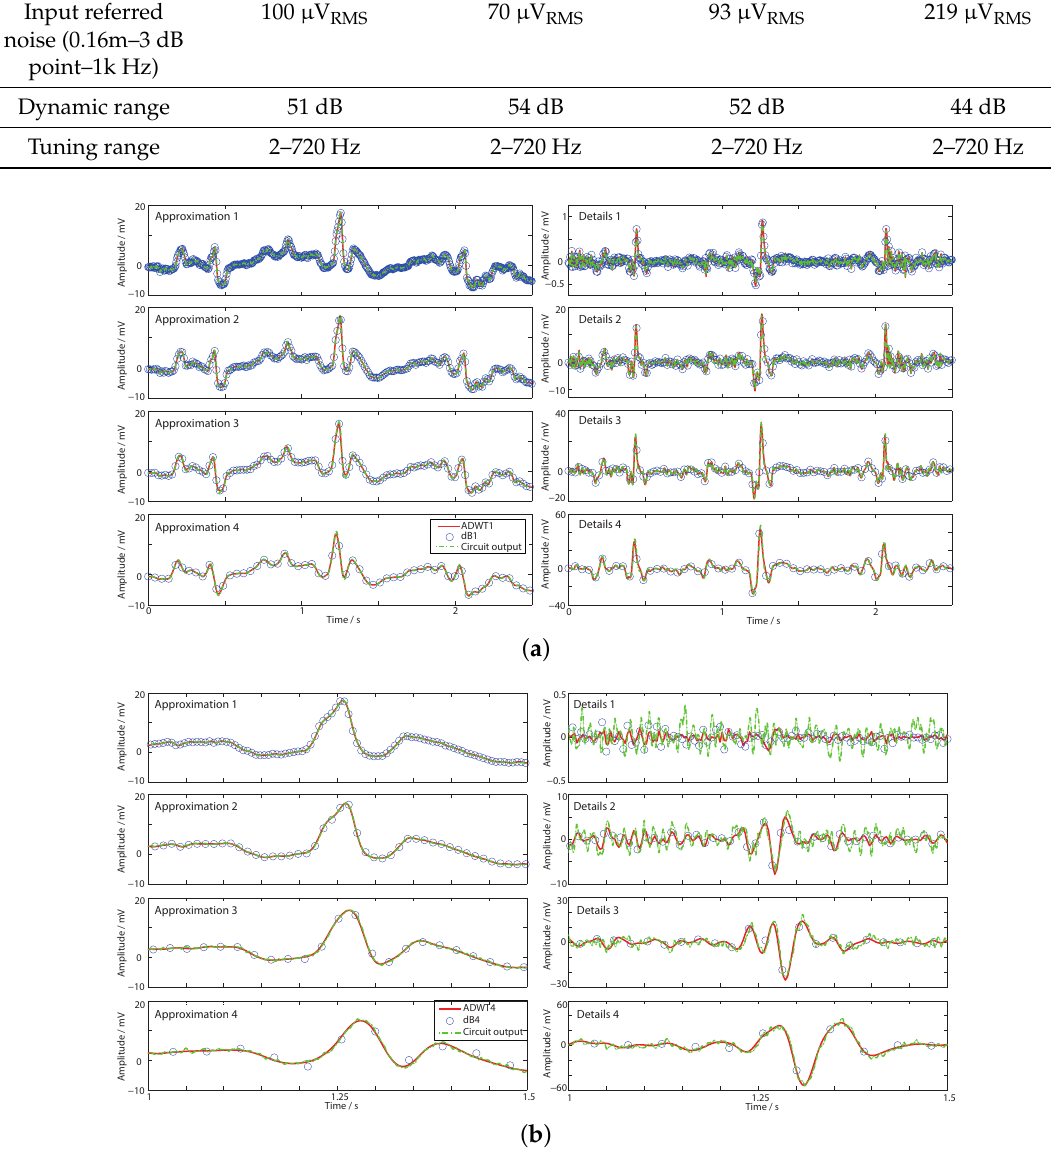
Figure 9. Transient response of the ADWT g m C circuits including noise. ( a ) First order ADWT1 for dB1; ( b ) Fourth order ADWT4 for